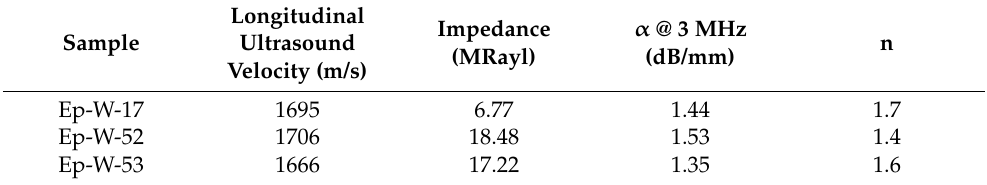
Table 11. Measured ultrasonic properties of the tungsten-loaded epoxy composites. Longitudinal Sample